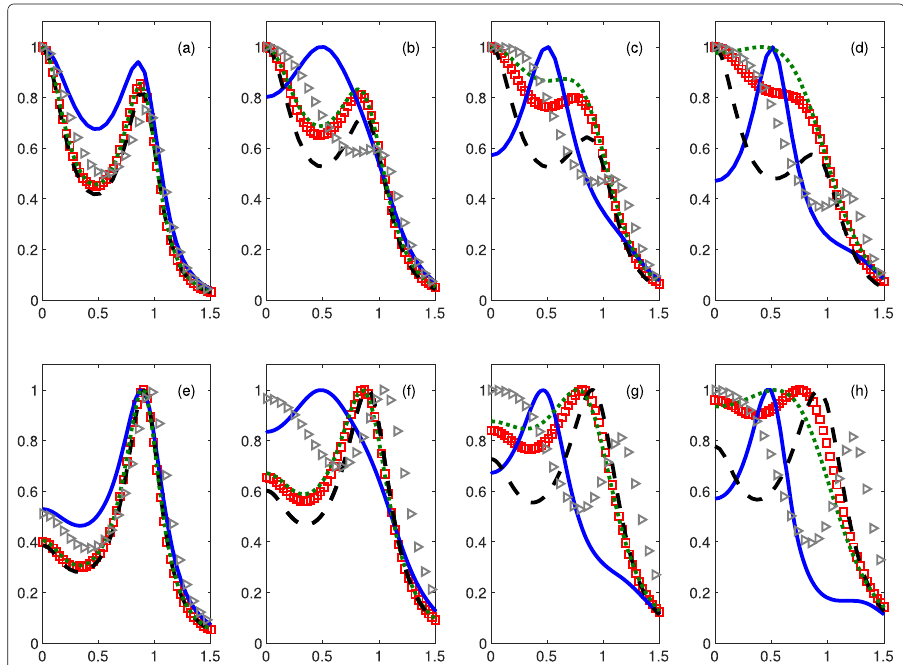
Fig. 7 Spectra of the spontaneous (top row) and coherent (bottom row) RBS. The horizontal and vertical axis are the normalized frequency and spectrum, respectively. Form the left to right, the Knudsen number in each column are 0.04, 0.06, 0.08, and 0.1, respectively. Solid, dashed, and dotted lines are the results from G13, R13, and R26 moment equations, respectively, while triangles are results from Eu’s generalized hydrodynamic